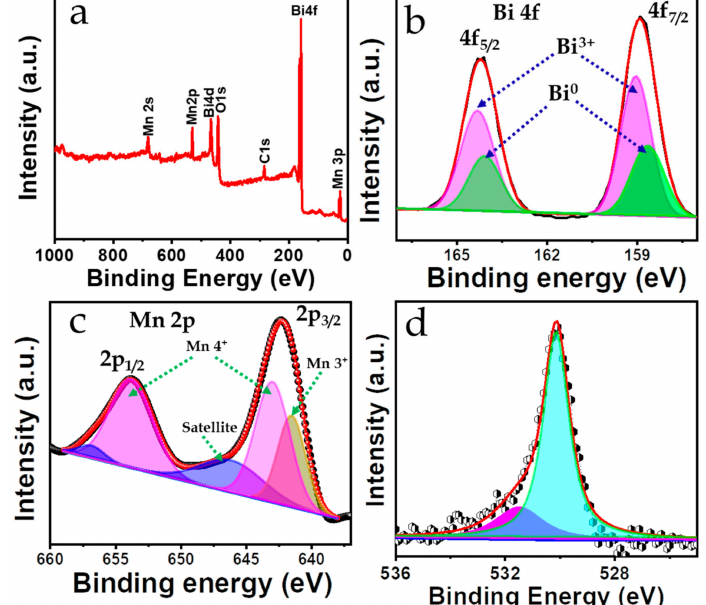
Figure 2. X -ray photoelectron spectroscopy (XPS) analysis, ( a ) full scan spectrum of Bi 2 O 3 -MnO 2 , ( b ) narrow scan of Bi 4f, ( c ) Mn 2p, and ( d ) O